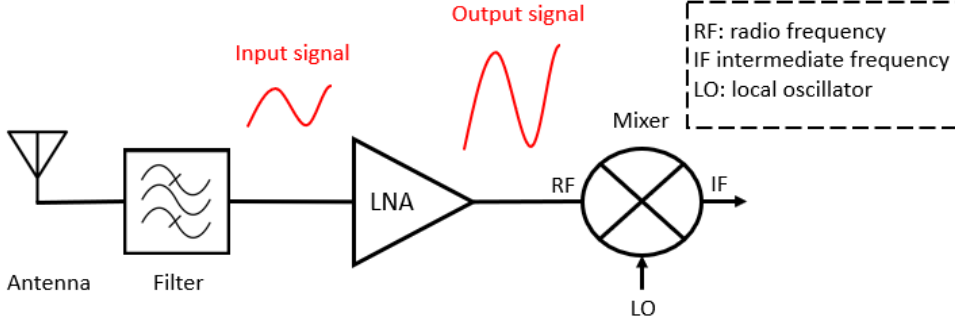
Figure 2. Low noise amplifier (LNA) block in front end antenna.